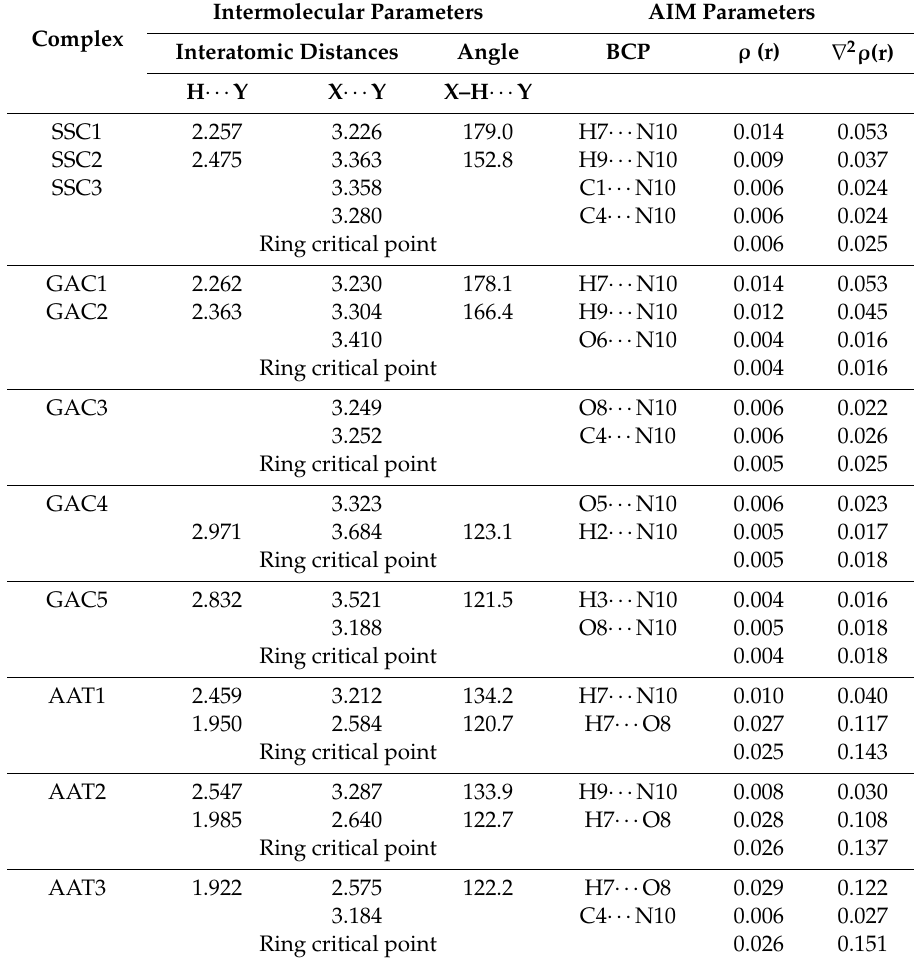
Table 1. Interatomic distances (Å), angles (degree) and electron density parameters of the bond (au) of the SSC, GAC and AAT complexes with N 2 (1:1) computed at the MP2 / 6-311 ++ G(2d,2p)